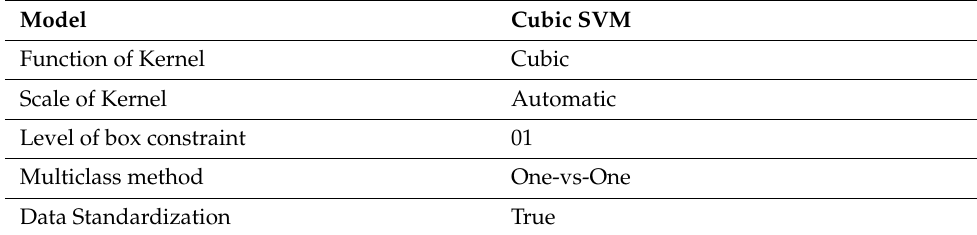
Table 4. Parameters of SVM.